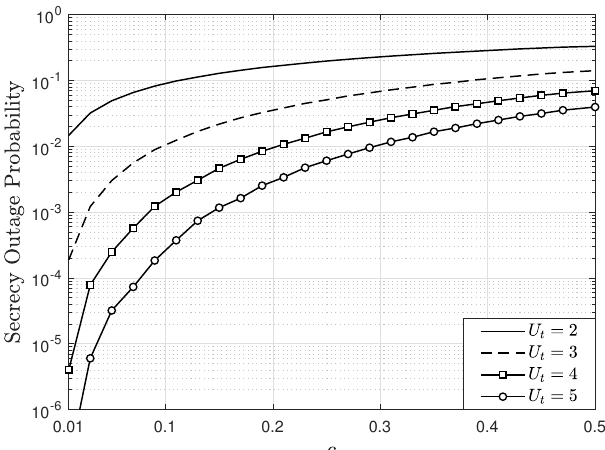
Figure 9. SOP as a function of c , parameterized by U t , considering M = 4, A = 2, A E = 2, U = 2, E b / N 0 = 15 dB, e = 0.1, and R = 1 bps in a Rician fading channel with K =